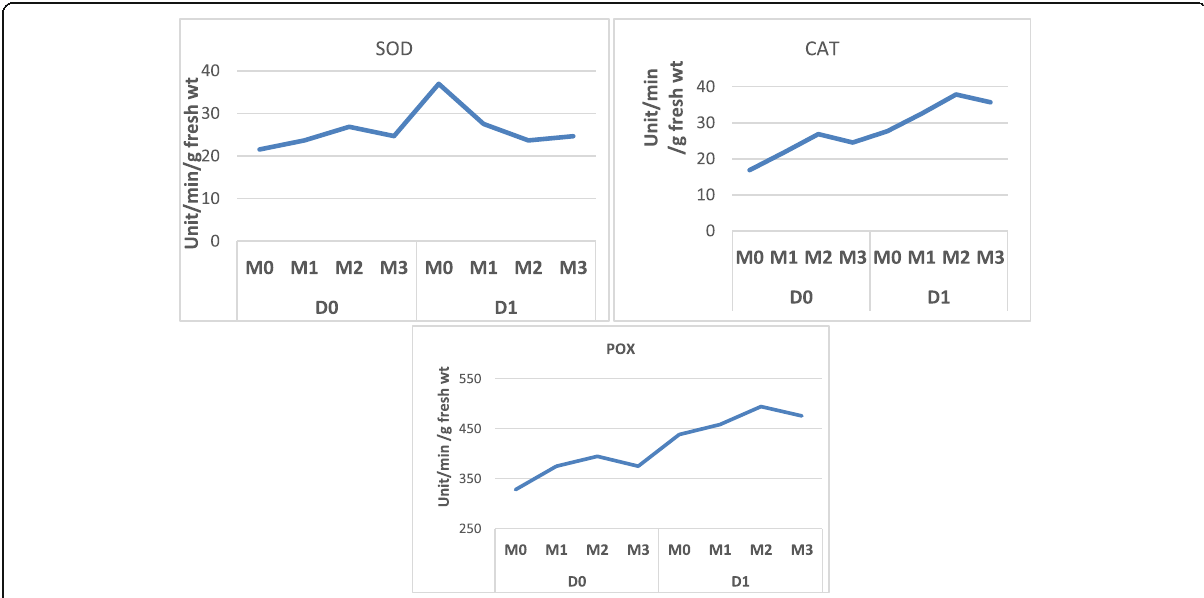
Fig. 4 Effect of melatonin (0, 50, 100, and 150 mM) on antioxidant enzymes (SOD, CAT, and POX unit/min/g fresh wt.) of M. oleifera plants subjected to drought stress (normal irrigation and skipping two irrigation